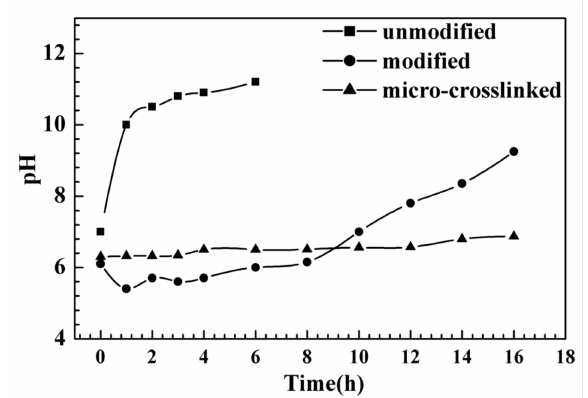
Figure 5. The pH change over time of original and surface modified AlN powder suspension at 50 ◦ C.